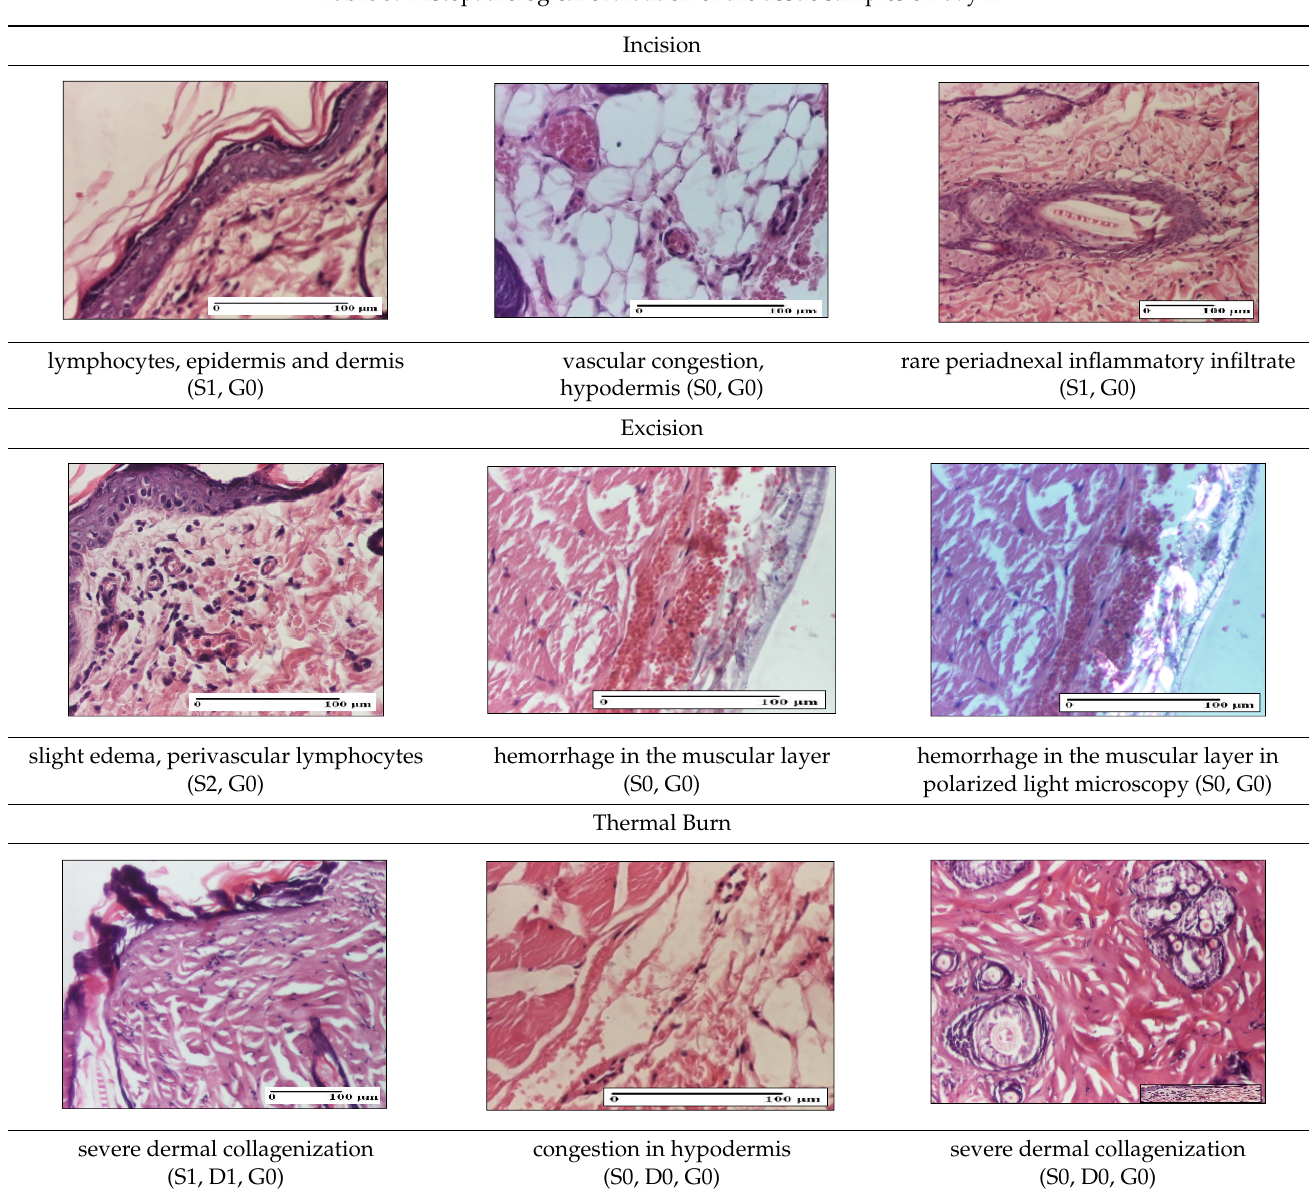
Table 3. Histopathological evaluation of the tissue samples on day 1 .